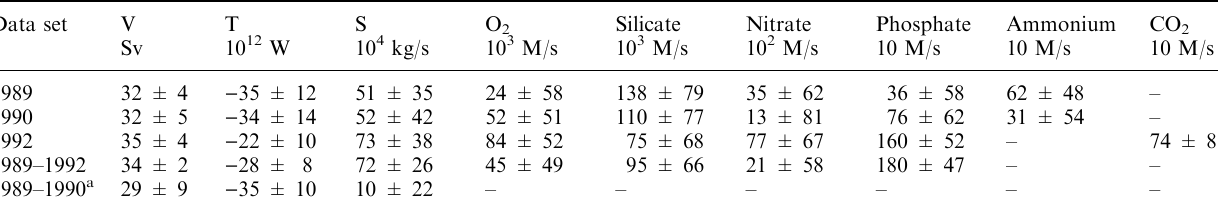
Table 3. Transport estimates Data